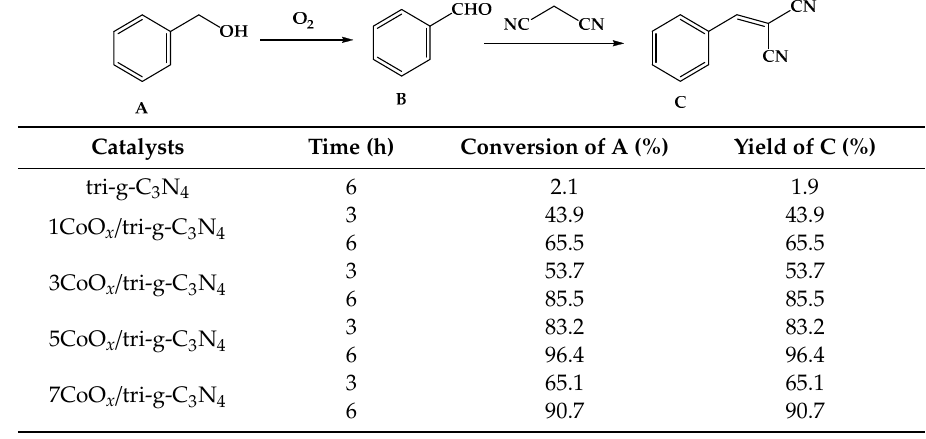
Table 4. Catalyst activity of tandem aerobic oxidation–Knoevenagel condensation reaction.